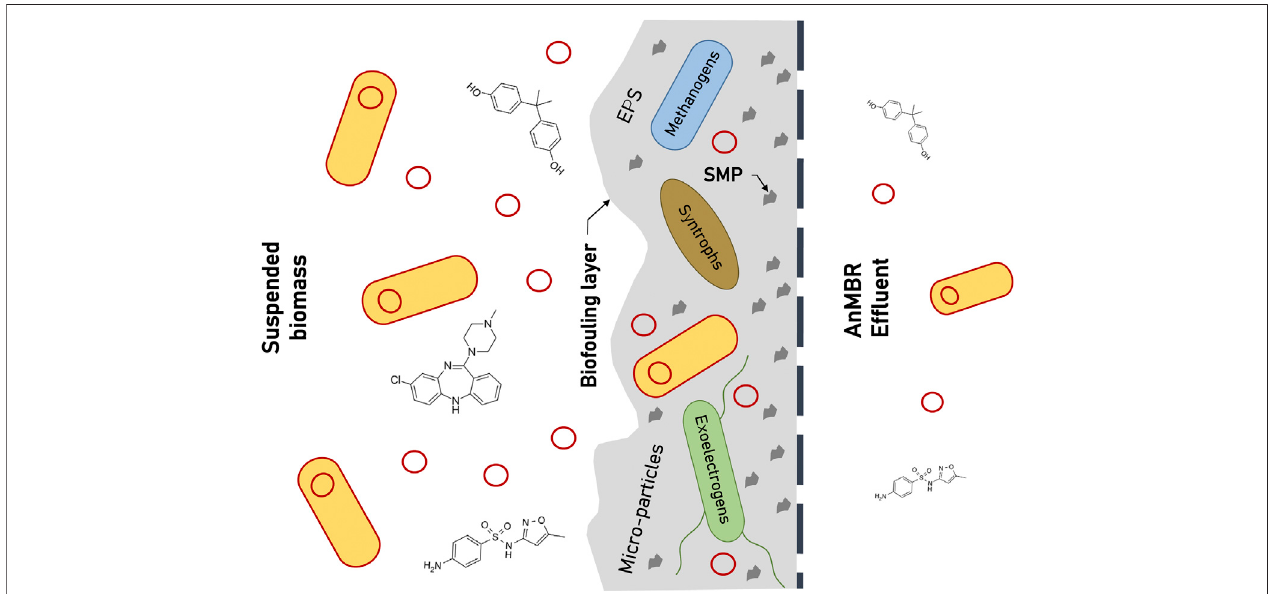
FIGURE 1 | Schematic representation of membrane bio fi lm components and communities that contribute to the enhanced removal of organic micropollutants (OMPs)andantibioticresistancegenes(ARGs)inanaerobicmembranebioreactor(AnMBR)systems.Redcirclesindicateextracellularantibioticresistanceelementsand yellow cells represent ARG-carrying